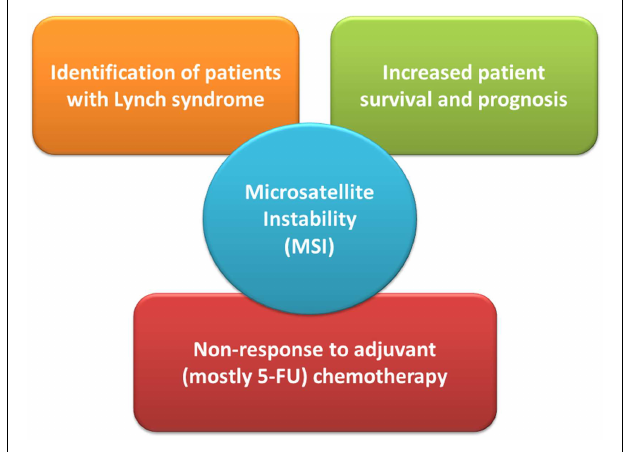
FIGURE 1 |The role of microsatellite instability (MSI) status in clinical management of colorectal cancer patients . 5-FU denotes